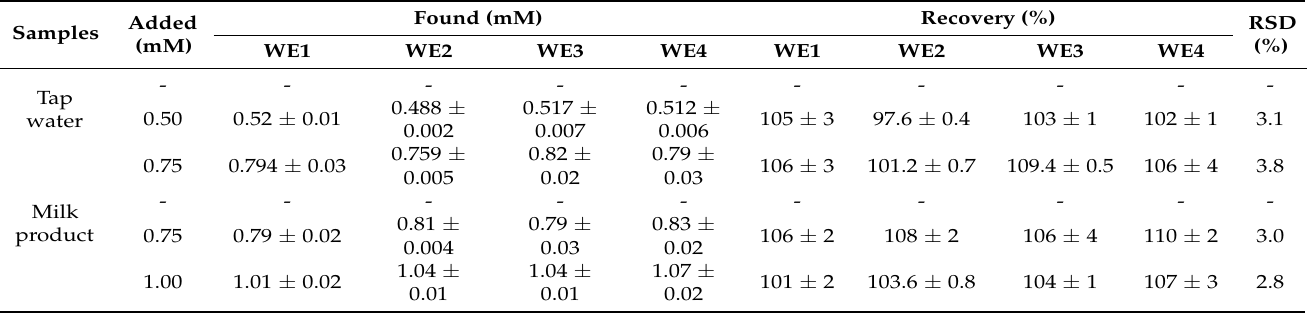
Figure 7. An example of the DPVs of standard nitrite concentration from 0 to 1.50 mM carried in 0.1 M PB at pH 7 ( a ) and the standard curves were obtained from the proposed electrode fabrication ( b ). Table 2. Determination of nitrite in tap water and milk product samples and the